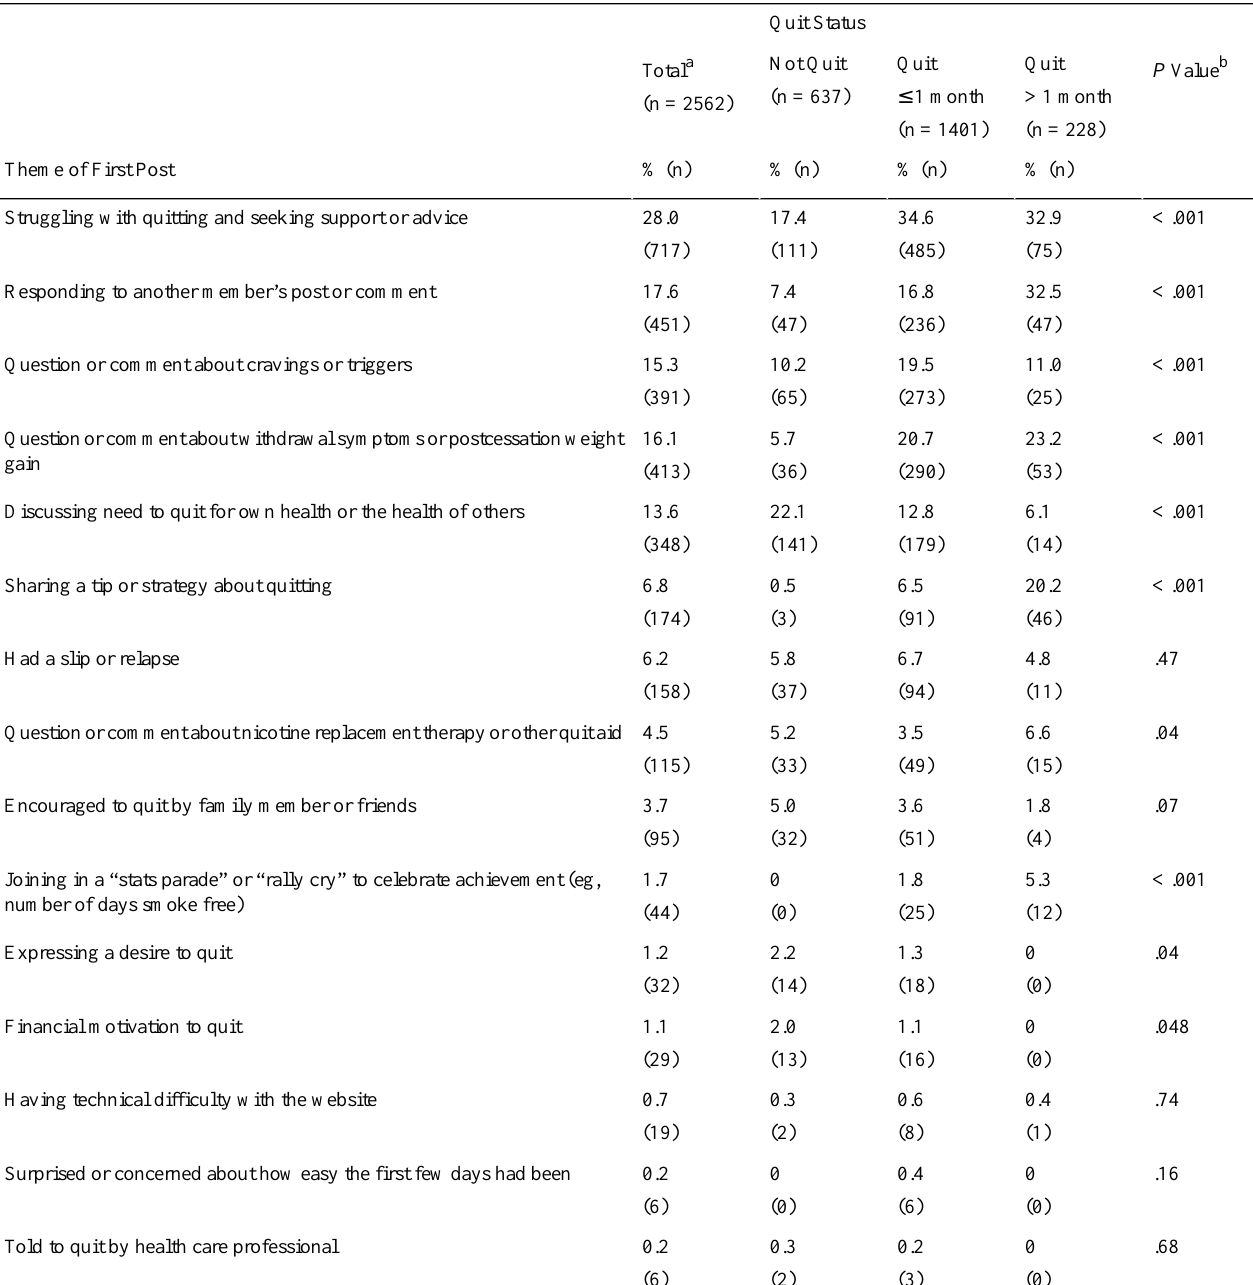
Table 2. Themes in first posts to support group by members of StopSmokingCenter.net version 5.0 (November 6, 2004, through May 15,